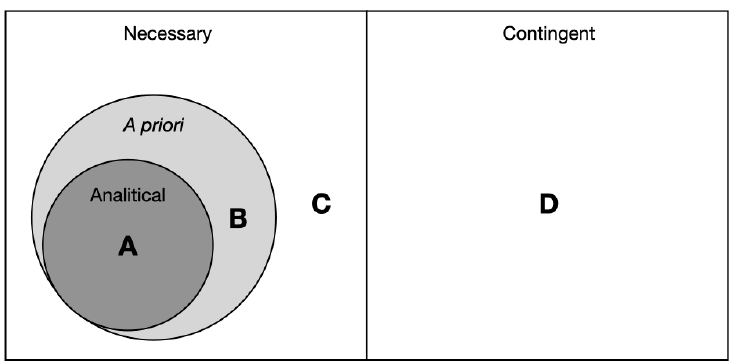
Figure 2. The relationship of the concepts of analytical, a priori, necessary, and their antipodes. The diagram indicates that there are synthetic a priori judgments, as Kant claimed, that there are neces- sary a posteriori judgments (whose necessity is recognized through experience), and that analytical and a priori judgments can never be contingent. Where is mathematical knowledge located on this diagram, at position A, B, C, or